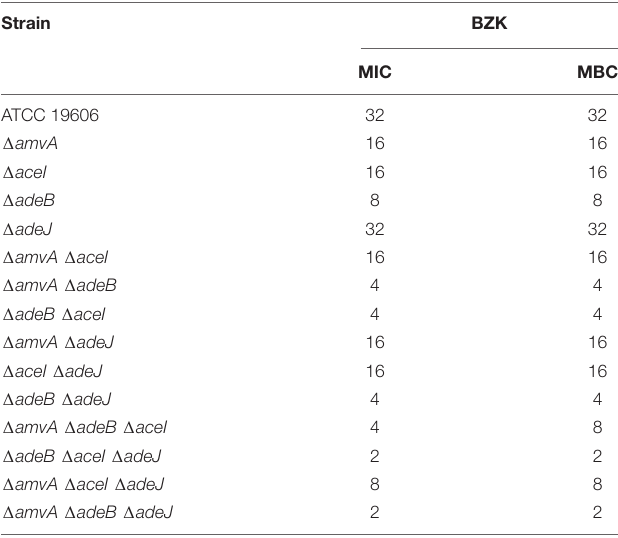
(cid:49) adeJ triple mutants ( Table 4 ). BZK susceptibility with MIC TABLE 4 | BZK MIC (mg/L) and MBC (mg/L) of A. baumannii ATCC 19606 parental strain and EP deletion mutants. Strain BZK MIC MBC ATCC 19606